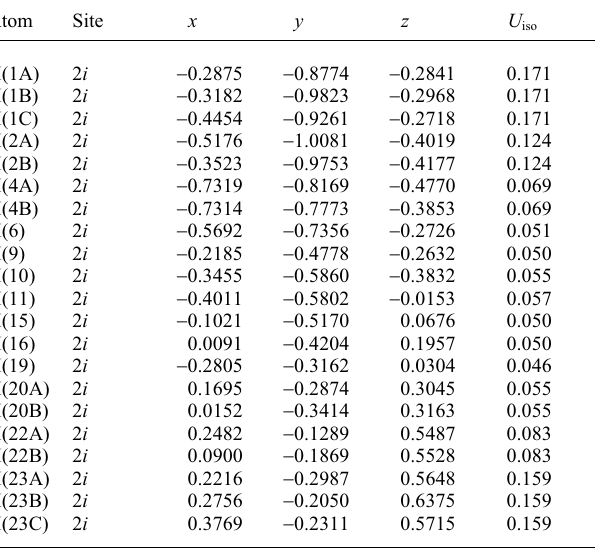
Table 2. Atomic coordinates and displacement parameters (in Å 2 )